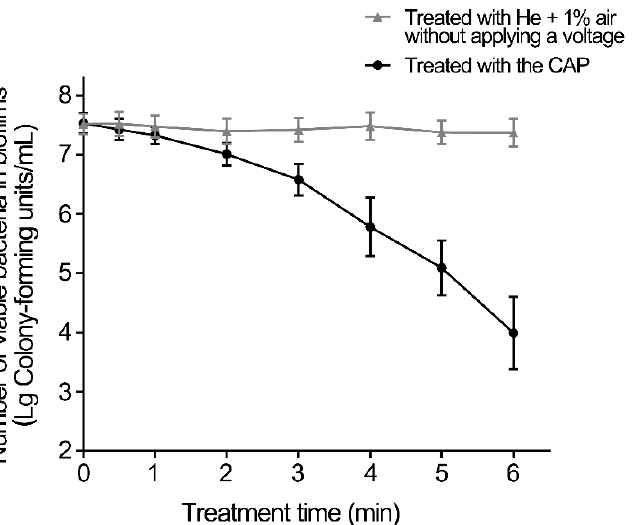
Figure 2. Inactivation effect on S. aureus biofilms of CAP. The biofilms were treated with CAP for the indicated times, and the CAP-treated and untreated biofilms were dispersed in 1 mL saline by sonication and vortexing. Serial dilutions of each biofilm were performed, and 10 µ L of each dilution was spotted onto TSB plates and incubated overnight at 37 °C. Error bars represent the standard deviation (SD).